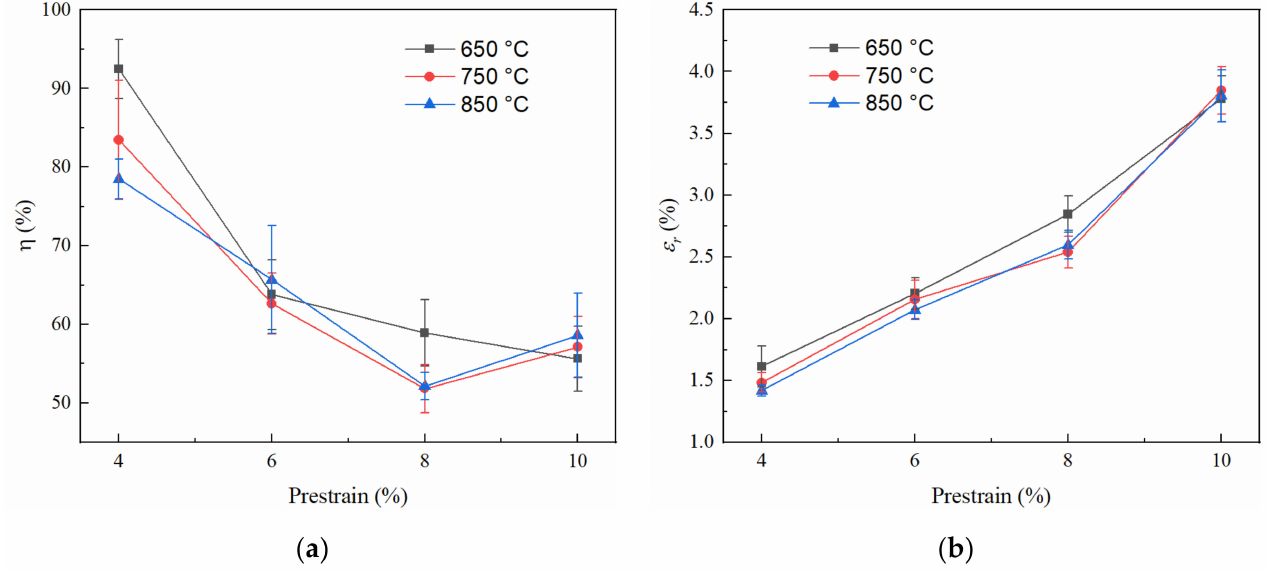
Figure 8. Shape memory effect of specimens subjected to shot peening and subsequent annealing at 650 ◦ C, 750 ◦ C, and 850 ◦ C temperatures: ( a ) shape recovery ratio and ( b ) recovery